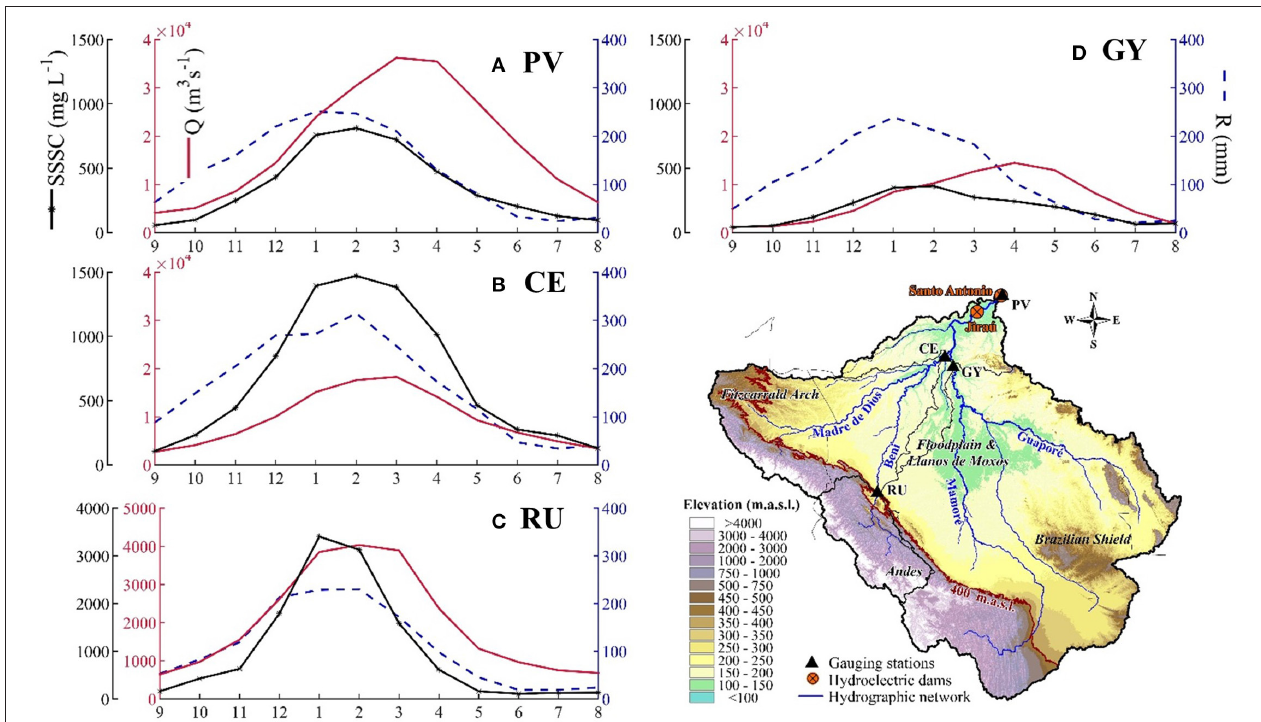
FIGURE 2 | Annual cycle (2003–2017) of rainfall (R, blue dash line), water discharge (Q, red line), and surface suspended sediment concentrations (SSSC, black asterisk line): (A) at Porto Velho (PV) on the Madeira River; (B) at Cachuela Esperanza (CE) on the Beni River; (C) at Rurrenabaque (RU) on the Andean Beni River; and (D) at Guayaramerin (GY) on the Mamoré River. Sources: for the rainfall: CHIRPS.v2 ( Funk et al., 2015), Q and SSSC adapted from Ayes et al. (2019a) and Ayes et al. (2019b) with data from SO-HYBAM, ANA, and SENAMHI. Please note that the two left y-axis differ in (C) because of the magnitude, and the x-axis is the hydrological year, from September (9) to August